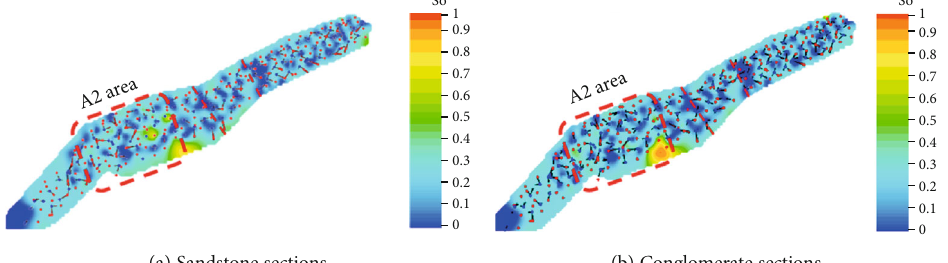
Figure 15: Oil saturation fi